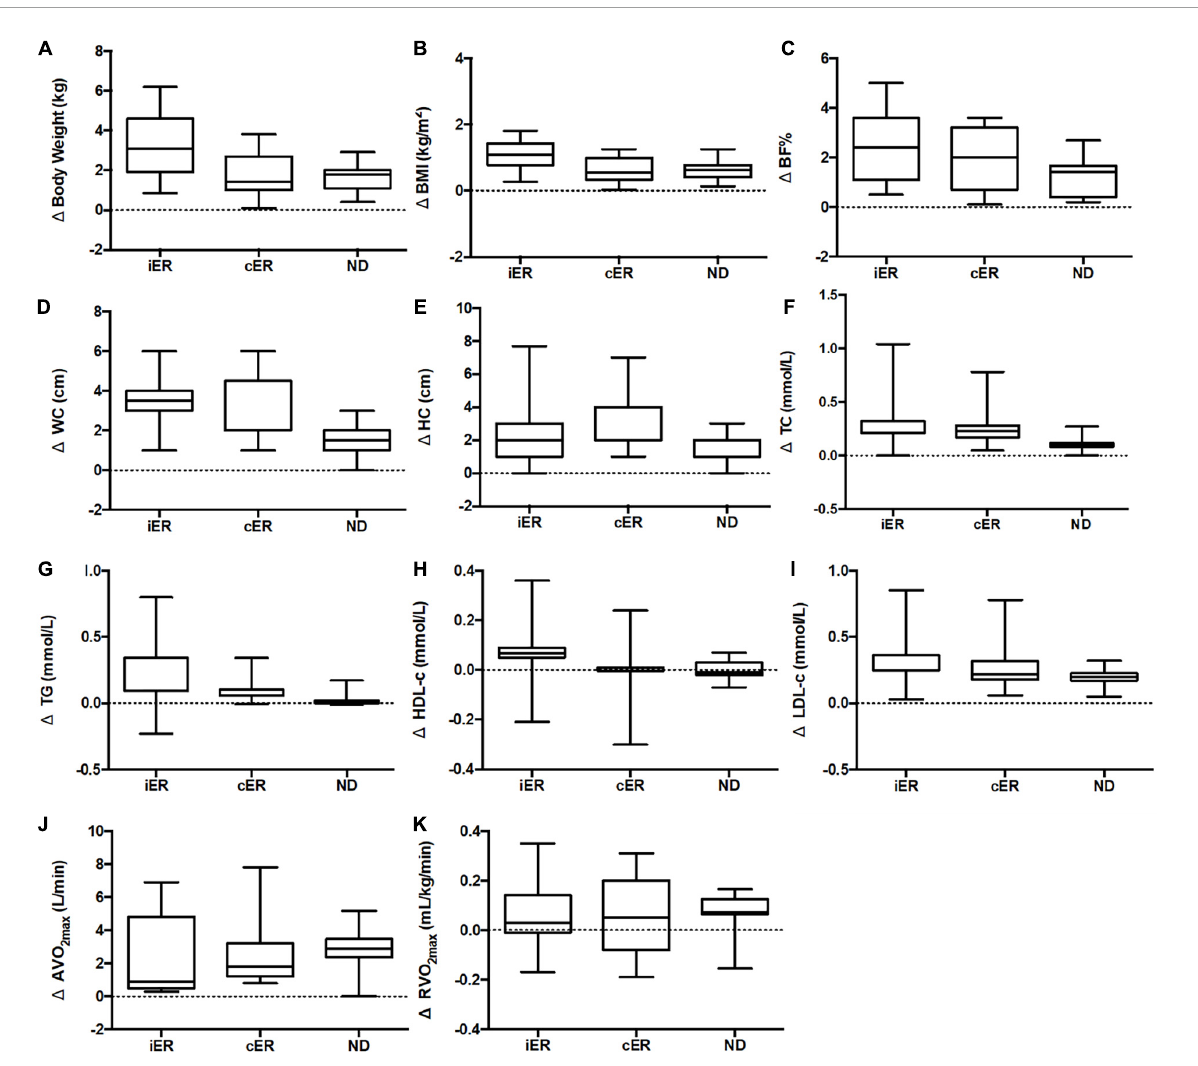
FIGURE3 (A) Change in body weight after 4 weeks of intervention. (B) Change in BMI after 4 weeks of intervention. (C) Change in BF% after 4 weeks of intervention. (D) Change in WC after 4 weeks of intervention. (E) Change in HC after 4 weeks of intervention. (F) Change in TC after 4 weeks of intervention. (G) Change in TG after 4 weeks of intervention. (H) Change in HDL-c after 4 weeks of intervention. (I) Change in LDL-c after 4-week of intervention. (J) Change in A˙VO 2 max after 4 weeks of intervention. (K) Change in R˙VO 2 max after 4 weeks of intervention. n = 16 in each group. Delta ( (cid:49) ), change from pre- post-intervention. Ier, intermittent energy restriction combined with HIIT group; cER, continuous energy restriction combined with HIIT group; ND, normal diet group combined with HIIT. BMI, body mass index; BF%, percentage body fat; WC, waist circumference; HC, hip circumference TC, total cholesterol; TG, triglyceride; LDL-c, low-density lipoprotein-cholesterol; HDL-c, high-density lipoprotein-cholesterol; A˙VO 2 max , absolute maximal oxygen uptake; R˙VO 2 max , the maximal oxygen uptake relative to body